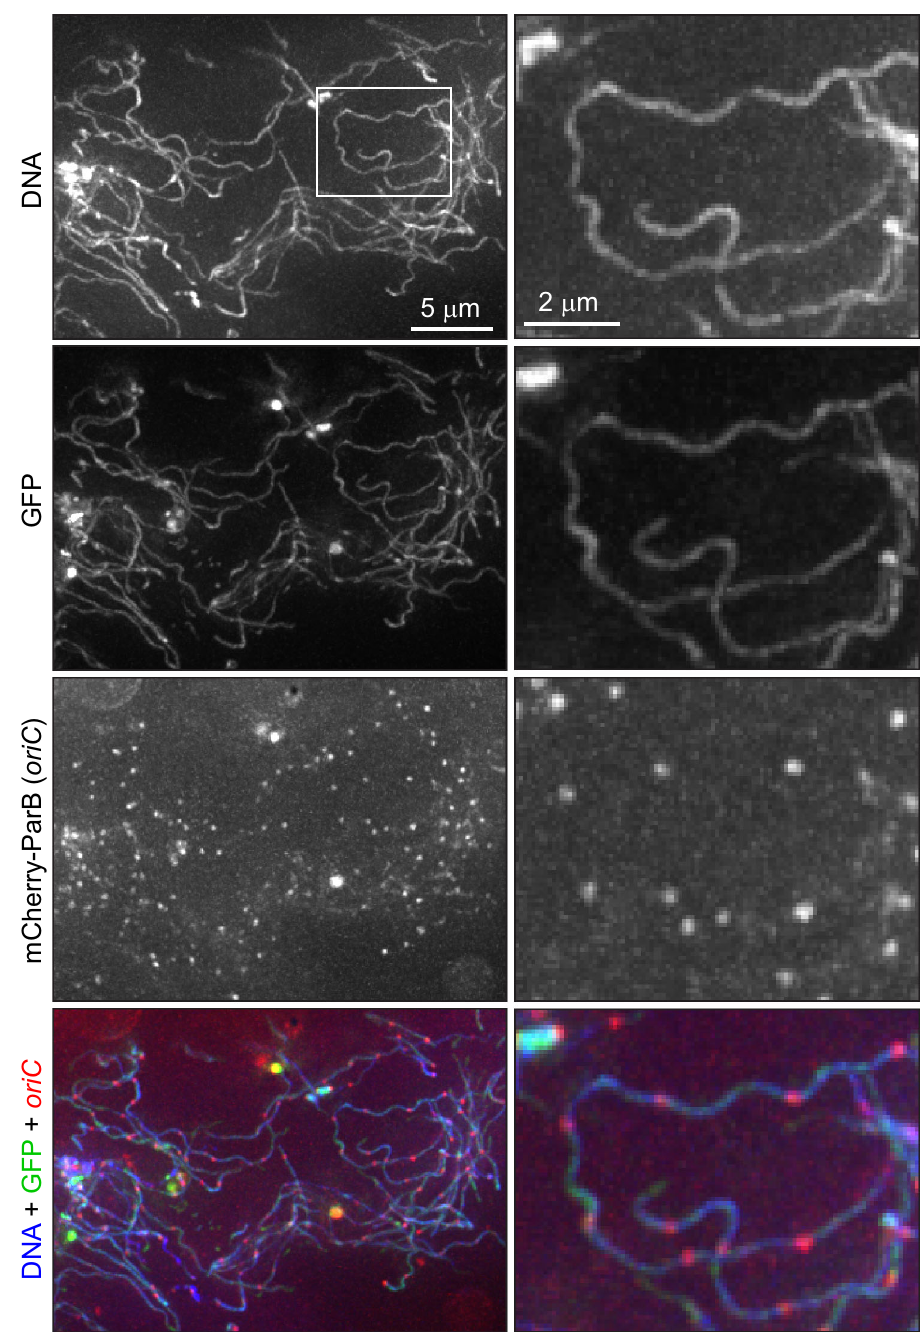
Fig. 3 | Tick-borne B. burgdorferi cells contain multiple chromosome copies. Images of cells of strain CJW_Bb474 in the midgut of a nymphal tick 10 days after feeding drop-off. DNA was stained with Hoechst 33342. The mCherry-ParB oriC